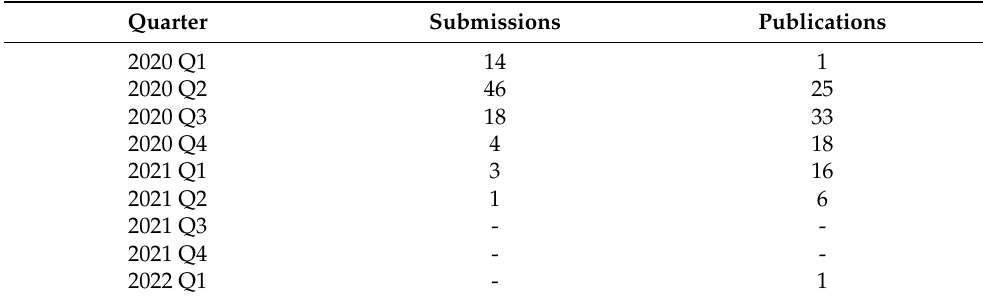
Table 3. Submission and publication